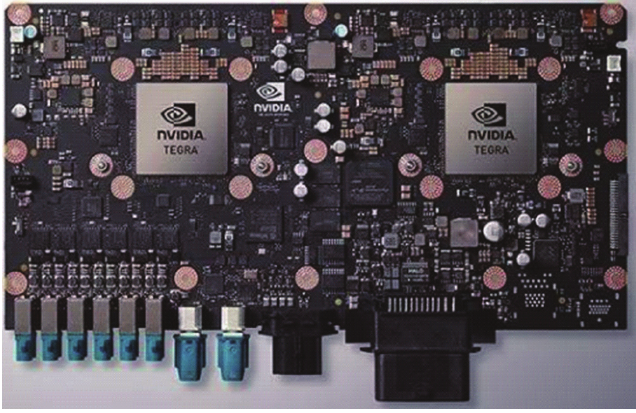
Figure 4. The NVIDIA DRIVE PX2 driverless car